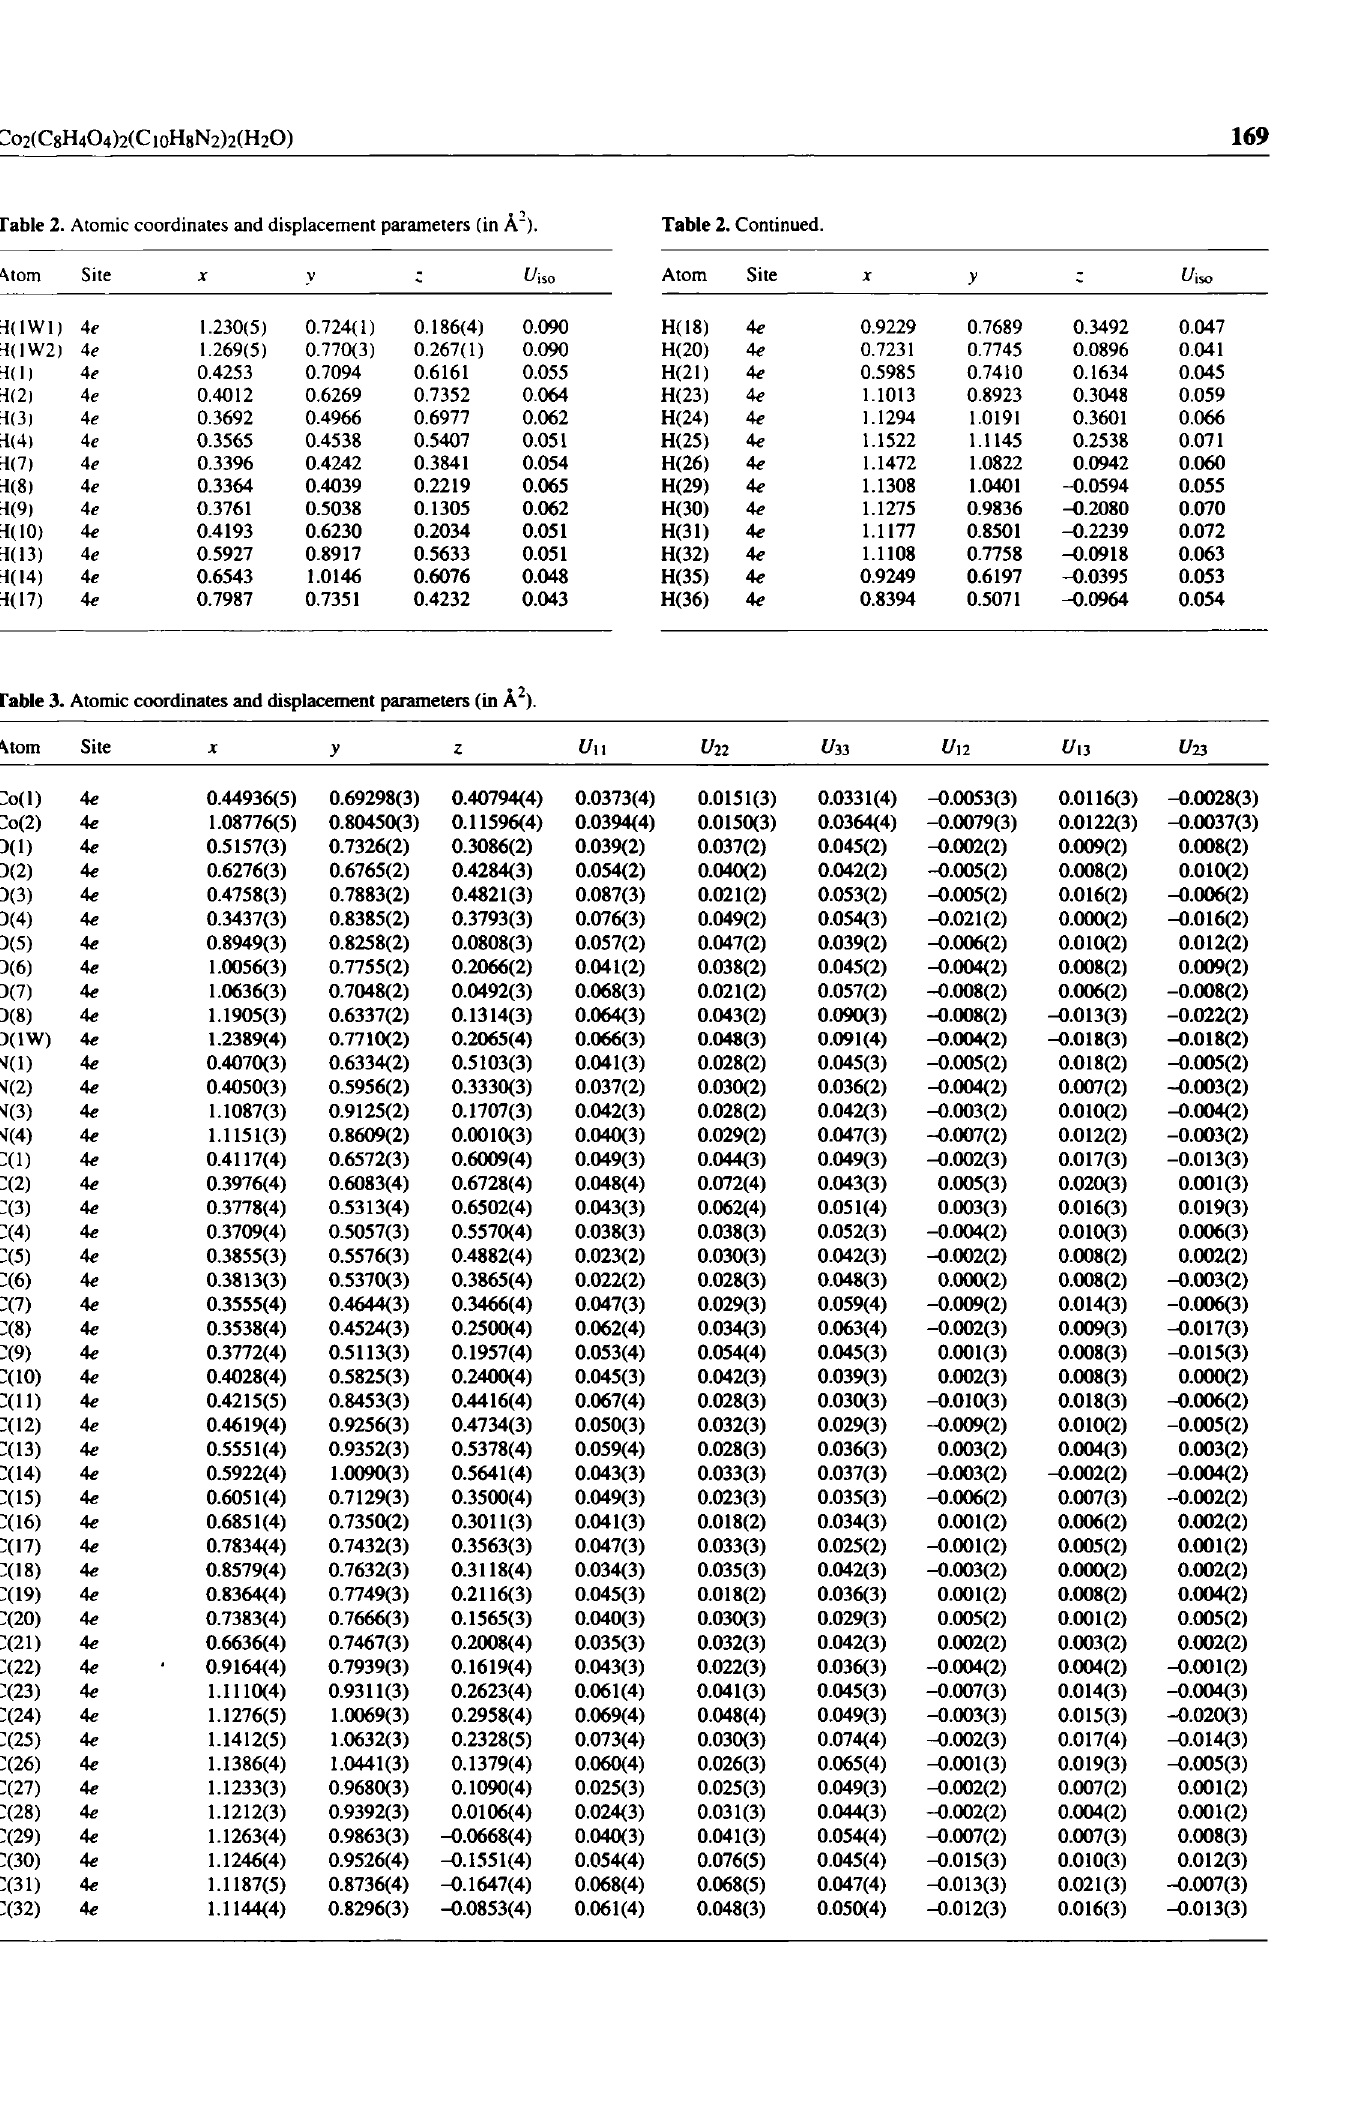
Table 3. Atomic coordinates and displacement parameters (in A 2